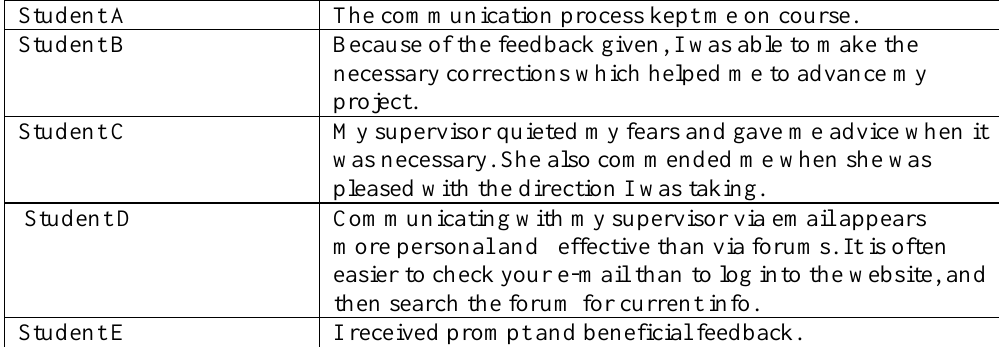
Table 1 Comments from Students on the Use of Asynchronous Mode of